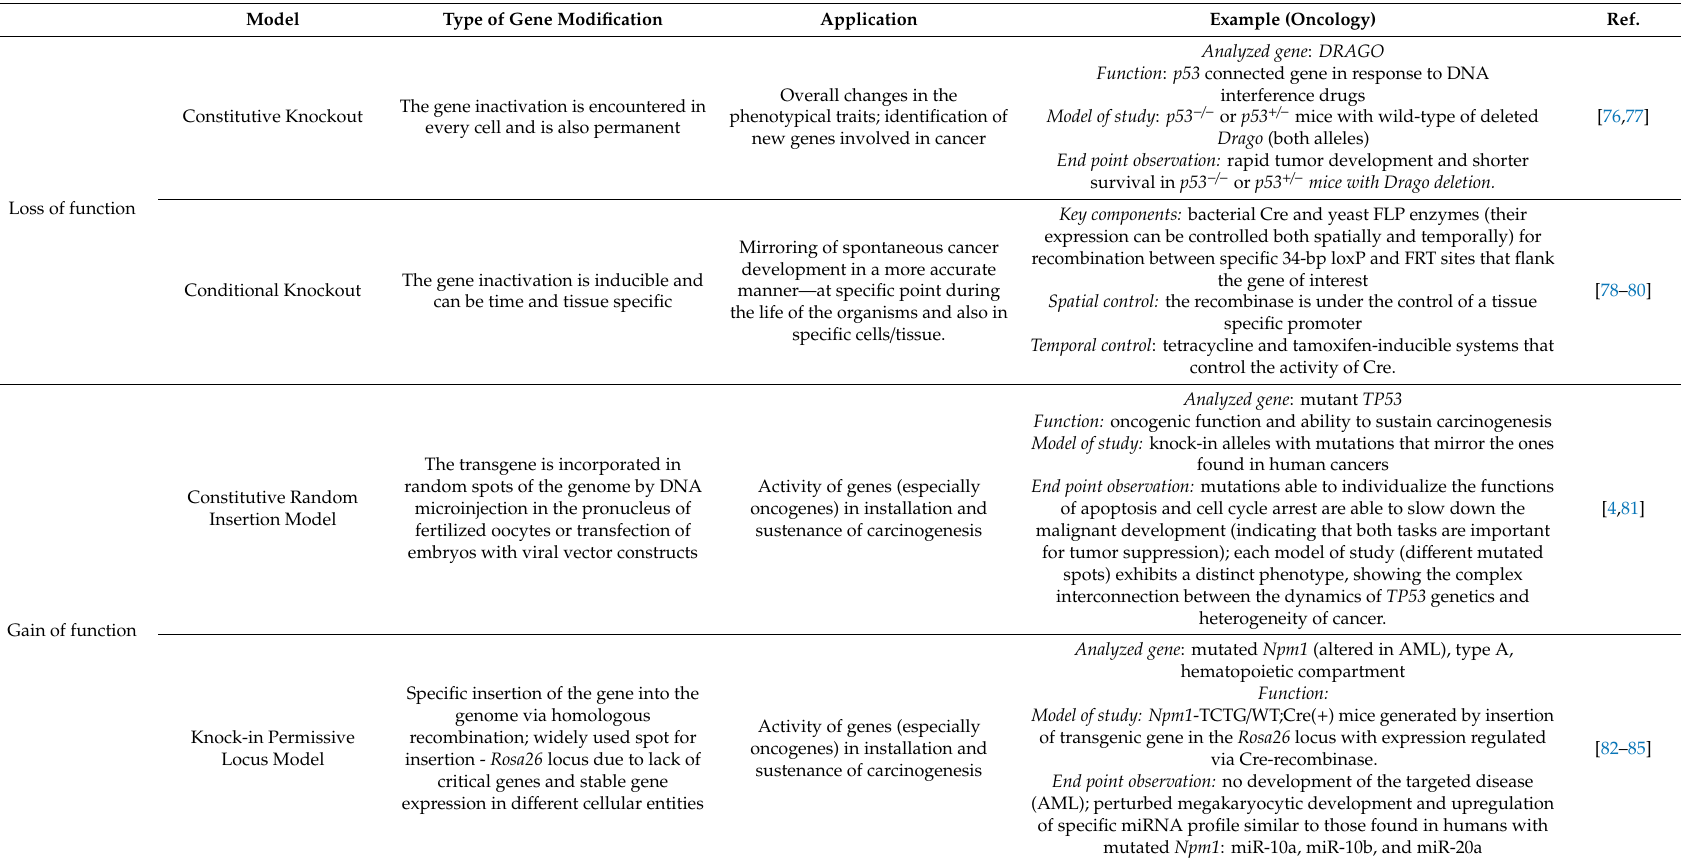
Table 3. Loss and gain of function transgenic mice models for cancer